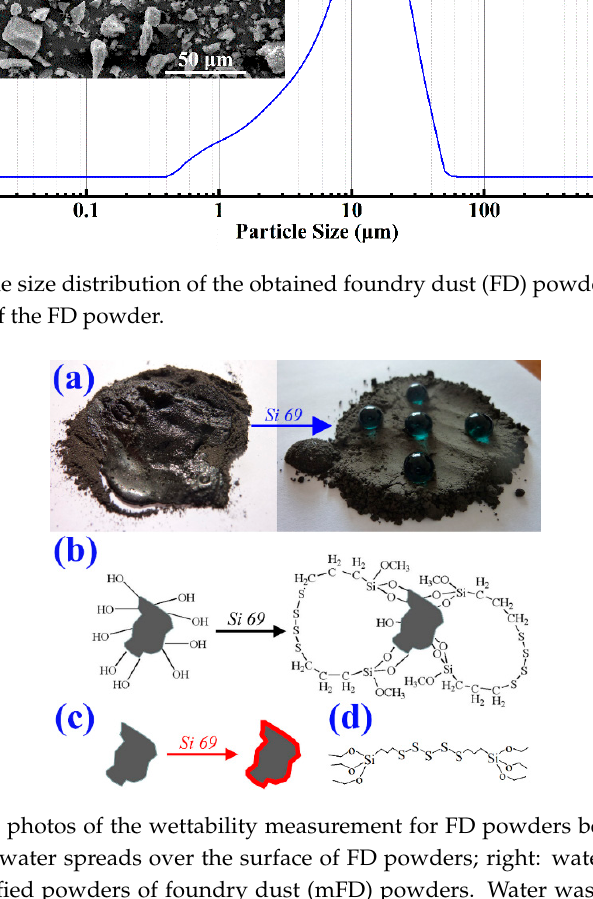
Figure 3. ( a ) Digital photos of the wettability measurement for FD powders before and after Si 69 modification. Left: water spreads over the surface of FD powders; right: water droplets stand on the surface of modified powders of foundry dust (mFD) powders. Water was dyed blue for clear observation; ( b ) chemical reaction between FD particles and Si 69; ( c ) the simplified expression of ( b ); ( d ) the chemical structure of Si